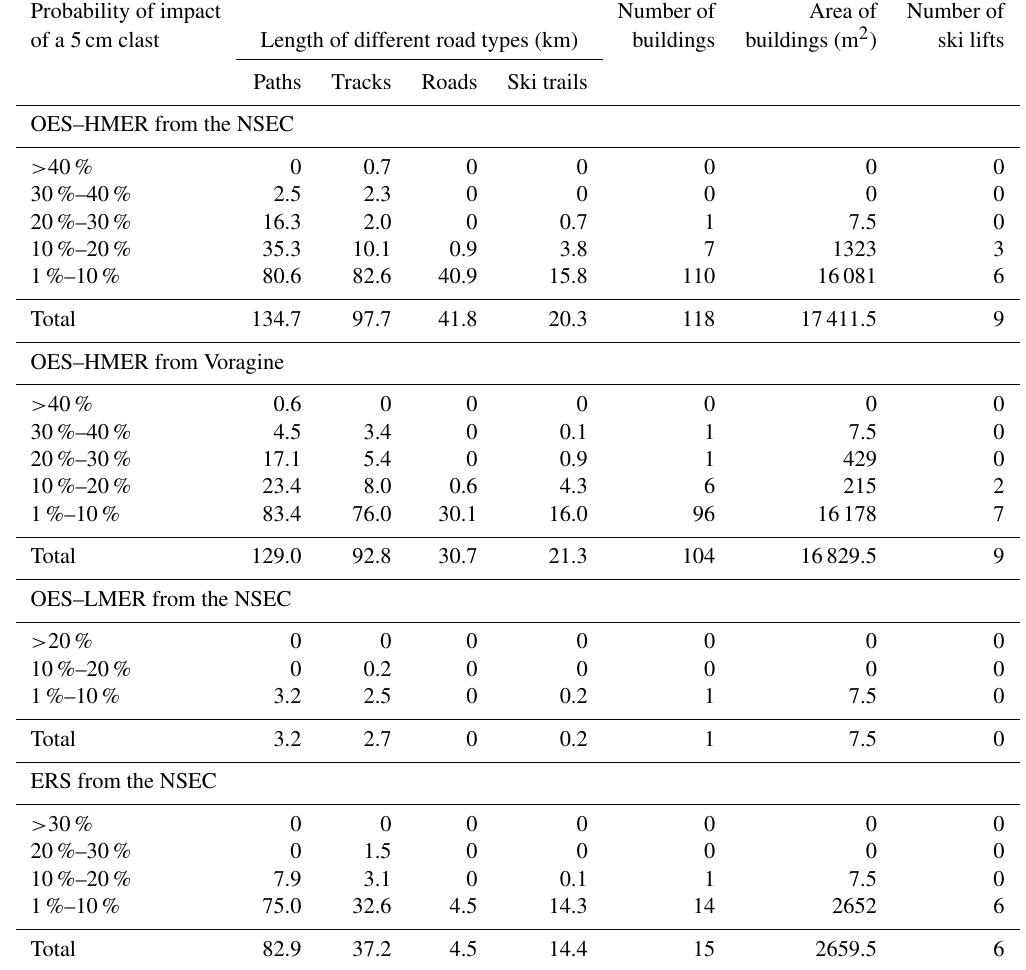
Table 3. Infrastructure within the hazard zone for the OES–HMER (from the NSEC and Voragine), OES–LMER (from the NSEC) and ERS (from the NSEC). The hazard zone is the area with a probability of impact from 5cm clast ≥ 1%. Probability of impact Number of Area of Number of of a 5cm clast Length of different road types (km) buildings buildings (m 2 ) ski lifts Paths Tracks Roads Ski trails